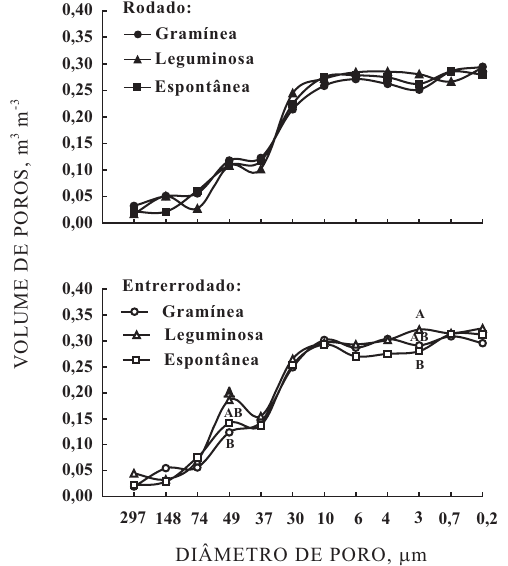
Figura 1. Volume de poros drenados para os diâmetros de poros nas posições de amostragem (rodado e entrerrodado) e vegetações (gramínea, leguminosa e espontânea). Médias seguidas da mesma letra, dentro da mesma posição de amostragem e diâmetro de poro, não diferem entre si pelo teste de Tukey a 5